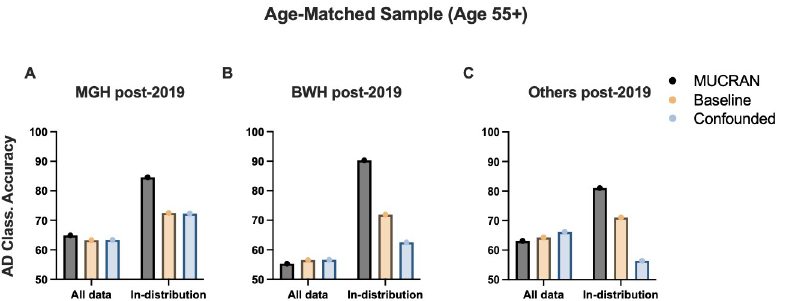
Fig 4. Comparison of classification accuracies on post-2019 data for an age-matched sample of patients aged 55 and older in MGH, BWH, and outside hospital datasets. A. Results in the internal, post-2019 MGH test set. B. Results on post-2019 data from Brigham and Women’s Hospital. C. Results from all outside hospital systems imported into Mass General Brigham. See Table 1 for the full results.